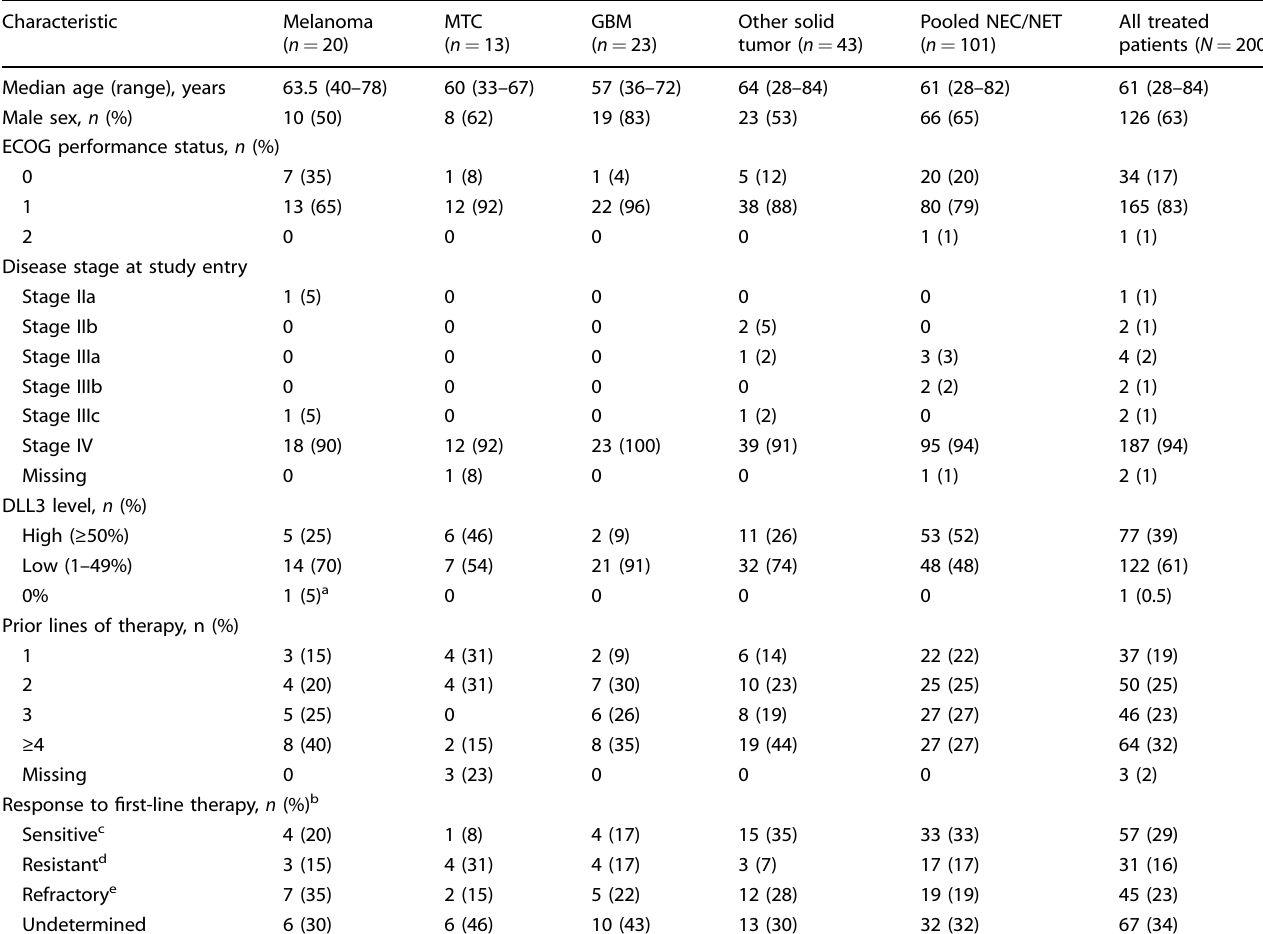
Table 1. Patient demographics and baseline characteristics.